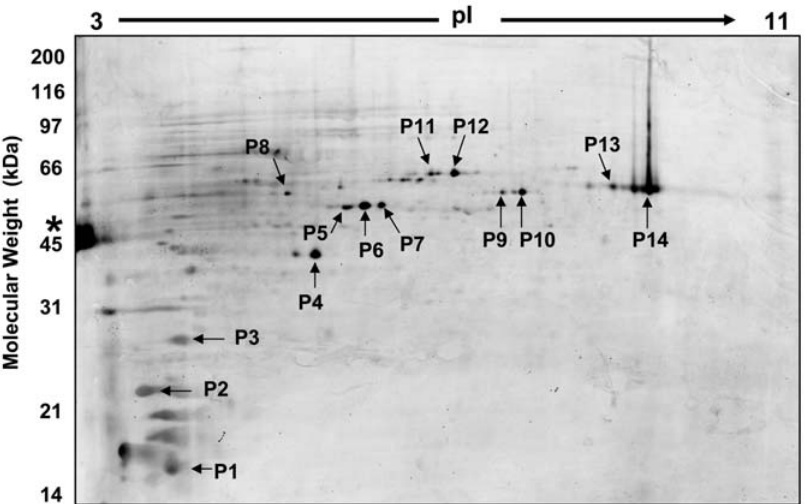
Figure 4. 2D gel of the S.solfataricus phospho-proteome 105 minutes after H 2 O 2 treatment. The gel was stained with phosphoprotein specific stain ProQ Diamond. Each of the numbered spots was picked and the proteins were identified using in-gel proteolysis followed LC-MS/MS.